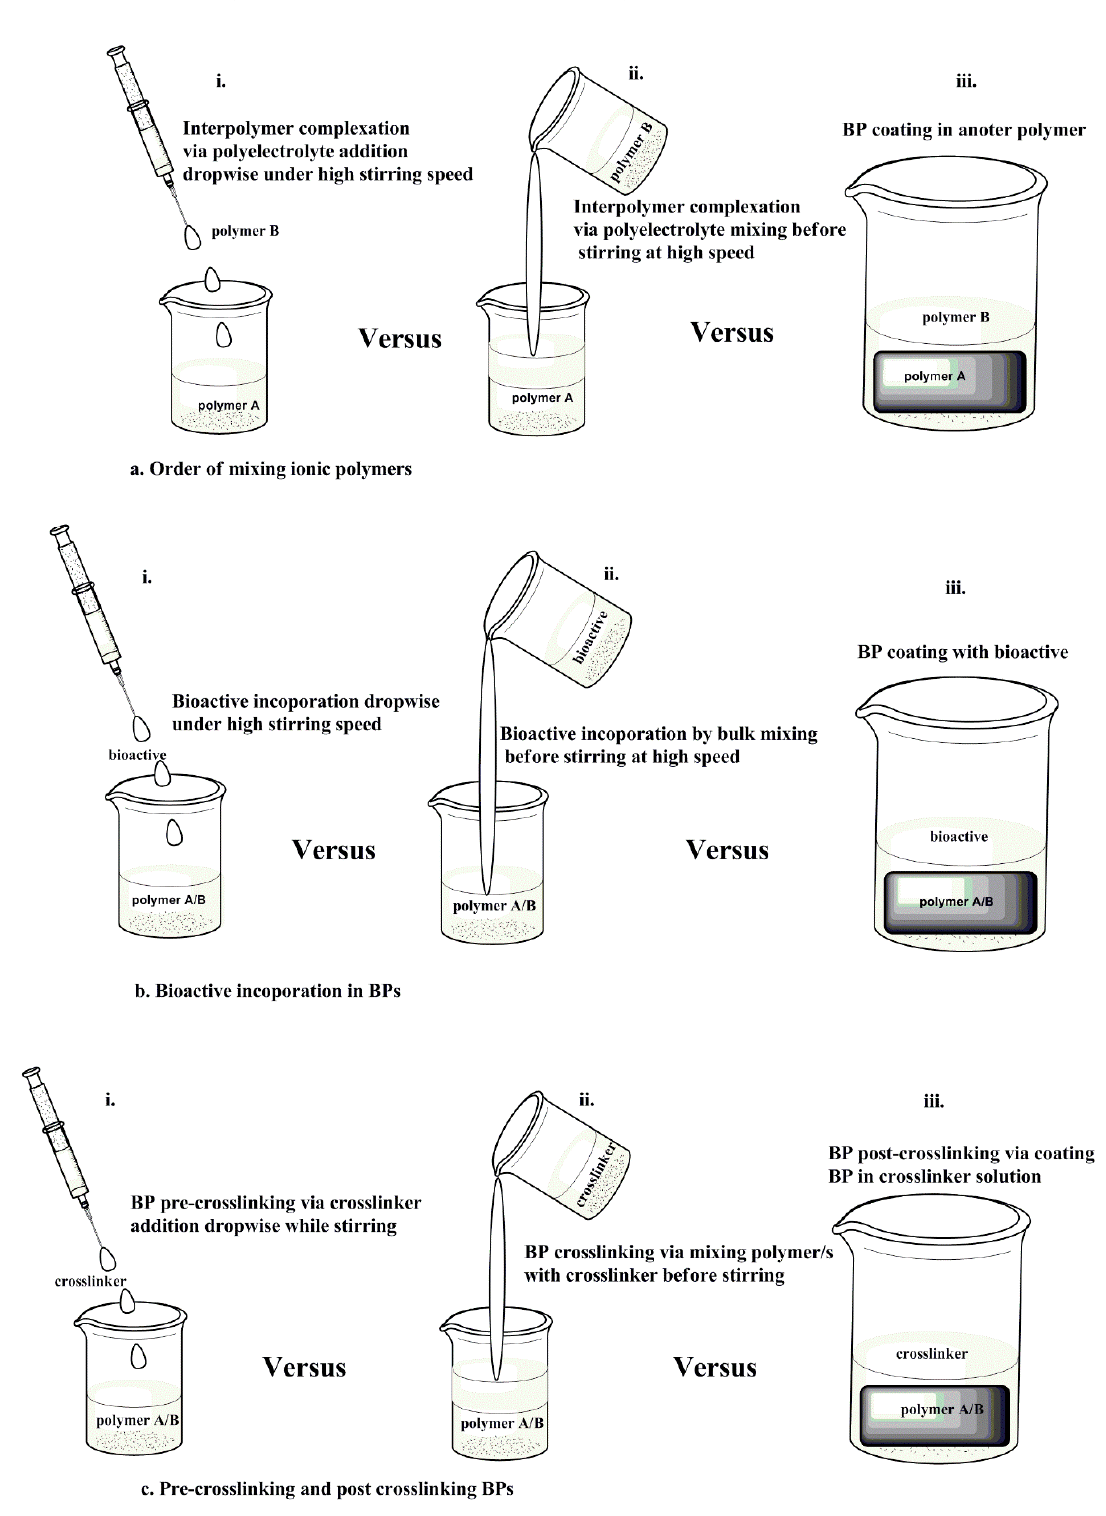
Figure 3. Schematic representation of the processing approaches of ionic polymers. ( a ) Order of mixing polymers; ( b ) bioactive incorporation into the interpolymer complex (IPC), and ( c ) crosslinking of the BMP.